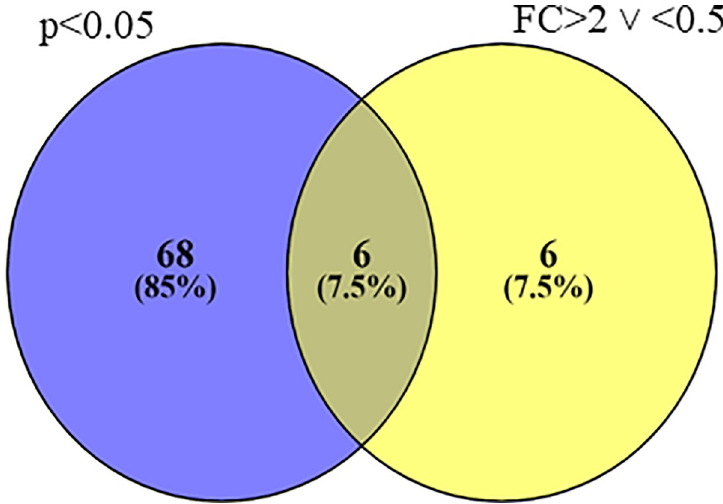
Fig 1. Protein groups. The Venn diagram illustrates the number of proteins with a fold-change greater than 2 or less than 0.5 (yellow colour), those with a p-value below 0.05 (blue colour), and those that meet simultaneously both criteria based on protein levels between inoculated and control